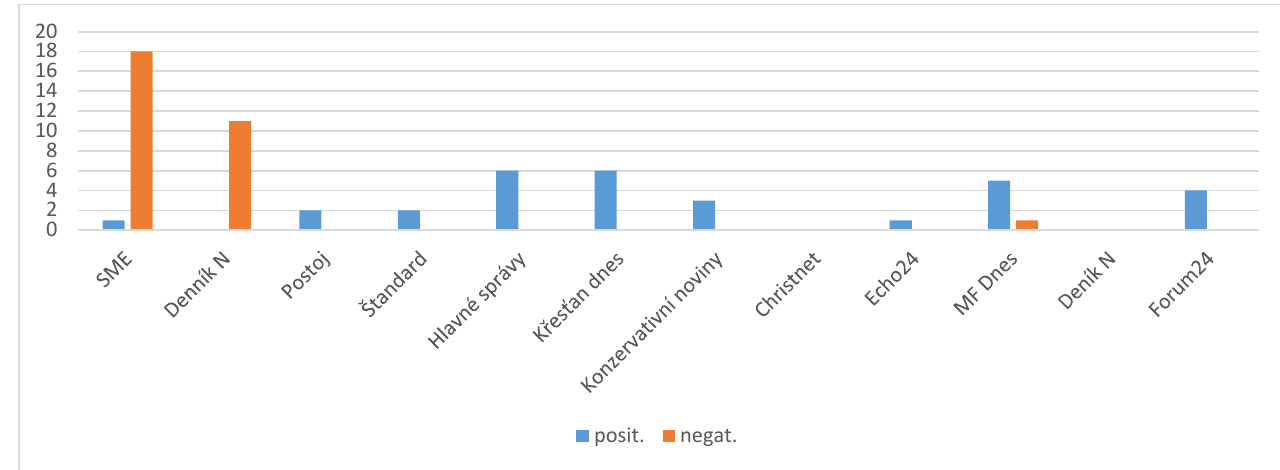
Figure 6. Occurrences of ‘discrimination’ as an argument (A5).